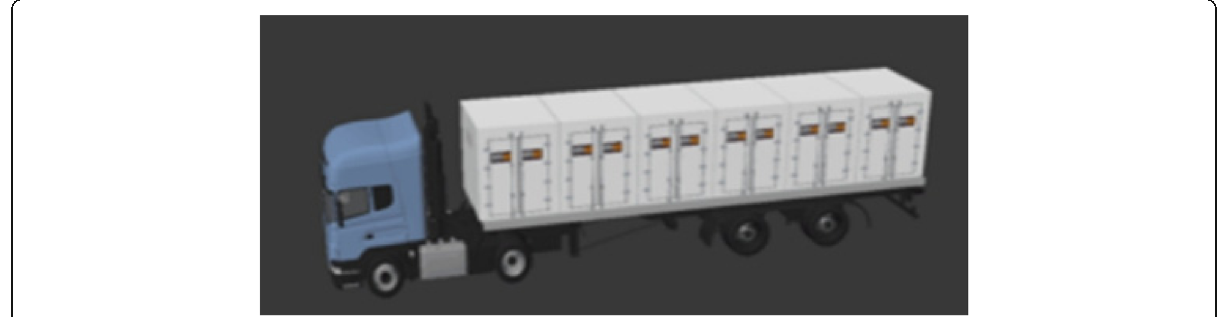
Fig. 5 A semi-trailer model loaded with refrigerated containers. Semitrailer is used to transport refrigerators and carry out trunk distribution. A semitrailer can carry multiple refrigerators, each of which corresponds to a medium-sized terminal customer. The last delivered refrigerated container is placed in the innermost part; the first served refrigerated container is placed on the outermost part for easy loading and unloading. Each refrigerator corresponds to a medium-end customer and is delivered without requiring boxes to be resorted and repacked. They are taken directly from the delivery vehicle that is responsible for regional distribution to customers. Each refrigerated container can be fixed with a buckle, easy to transport. This way saves